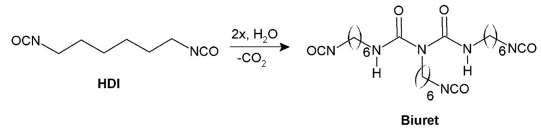
Figure 5. Isocyanate chemistry with hexamethylene diisocyanate (HDI) 23,35,36 .